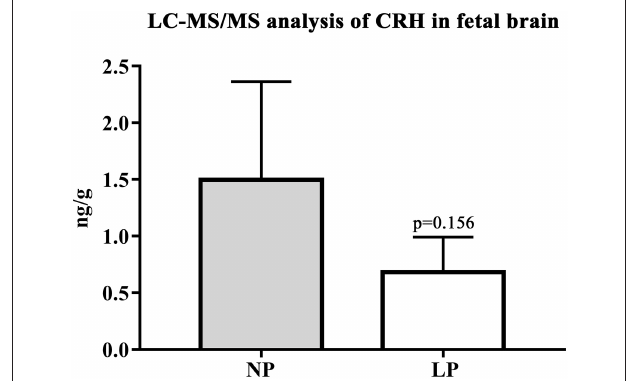
FIGURE 4 | LC-MS/MS analysis of local CRH levels in fetal brain. Differences of CRH of NP ( n = 4) and LP ( n = 5) group in brain given in ng/g. Legend: Gray column represents NP ( n = 4) group, white column represents LP ( n = 5)